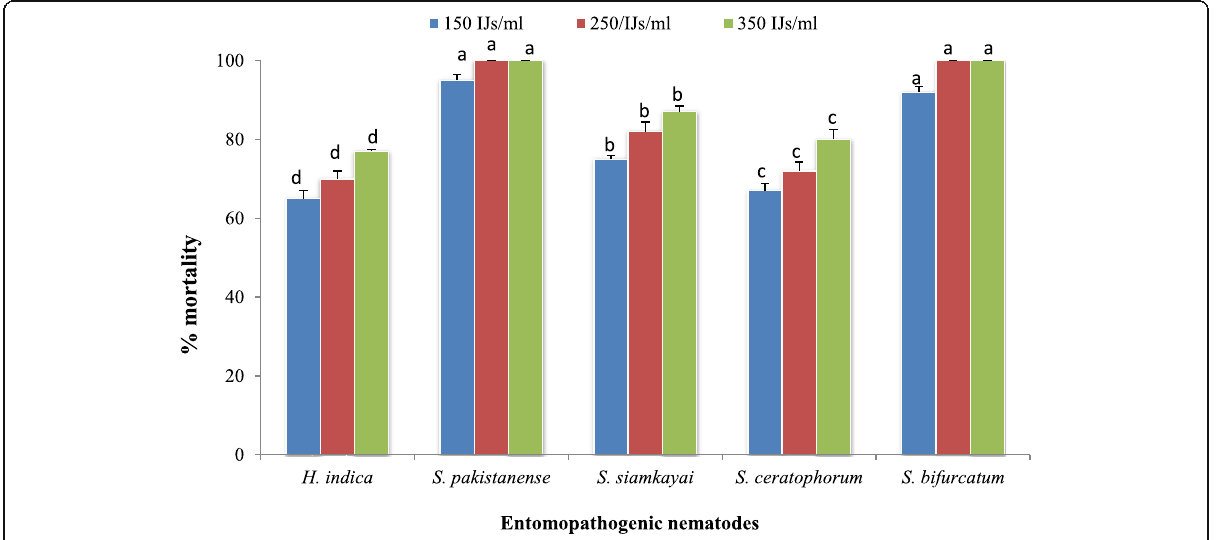
Fig. 1 Biocontrol potential of entomopathogenic nematodes against Microtermes obesi on filter